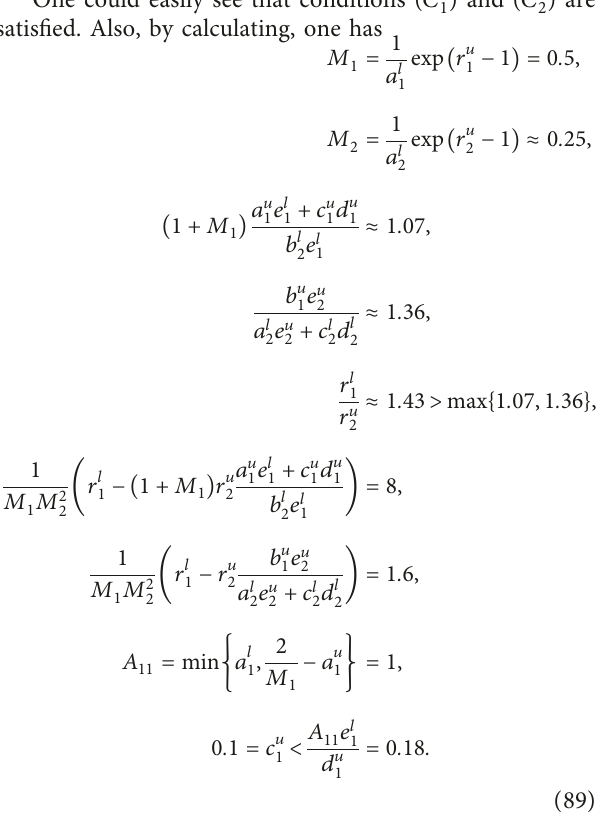
x k ,x k ,u k ,u k of system (86), with the initial conditions 1 ( 2 ( 1 ( 2 ( ( ) ) ) )) ... , n, n , 1 . 1 , 0 . 7 , 1 . 5 , 2 . 3 , s 1 , .. . , ) ( ) (cid:31) − − +